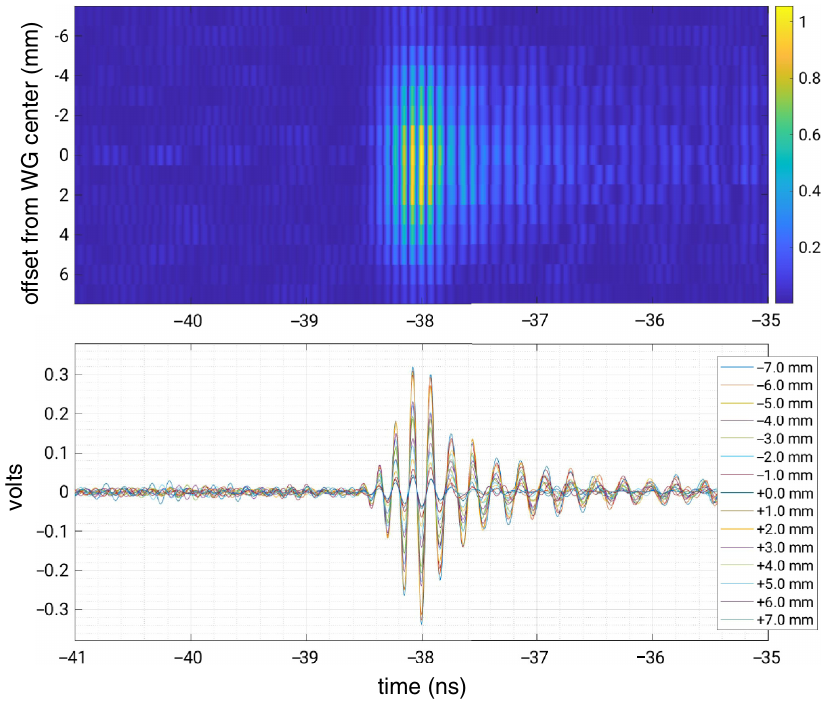
FIG. 11. Top: a two-dimensional image of the amplitude of the time-domain response in the vicinity of the primary shower pulse. The vertical axis is offset relative to waveguide center, and the horizontal axis is time. Bottom: overlay of the waveforms for all offsets, labeled by their offset relative to